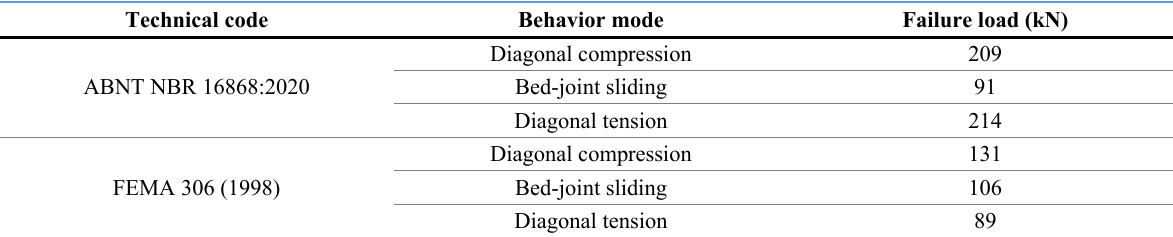
Table 3. Masonry failure loads by technical